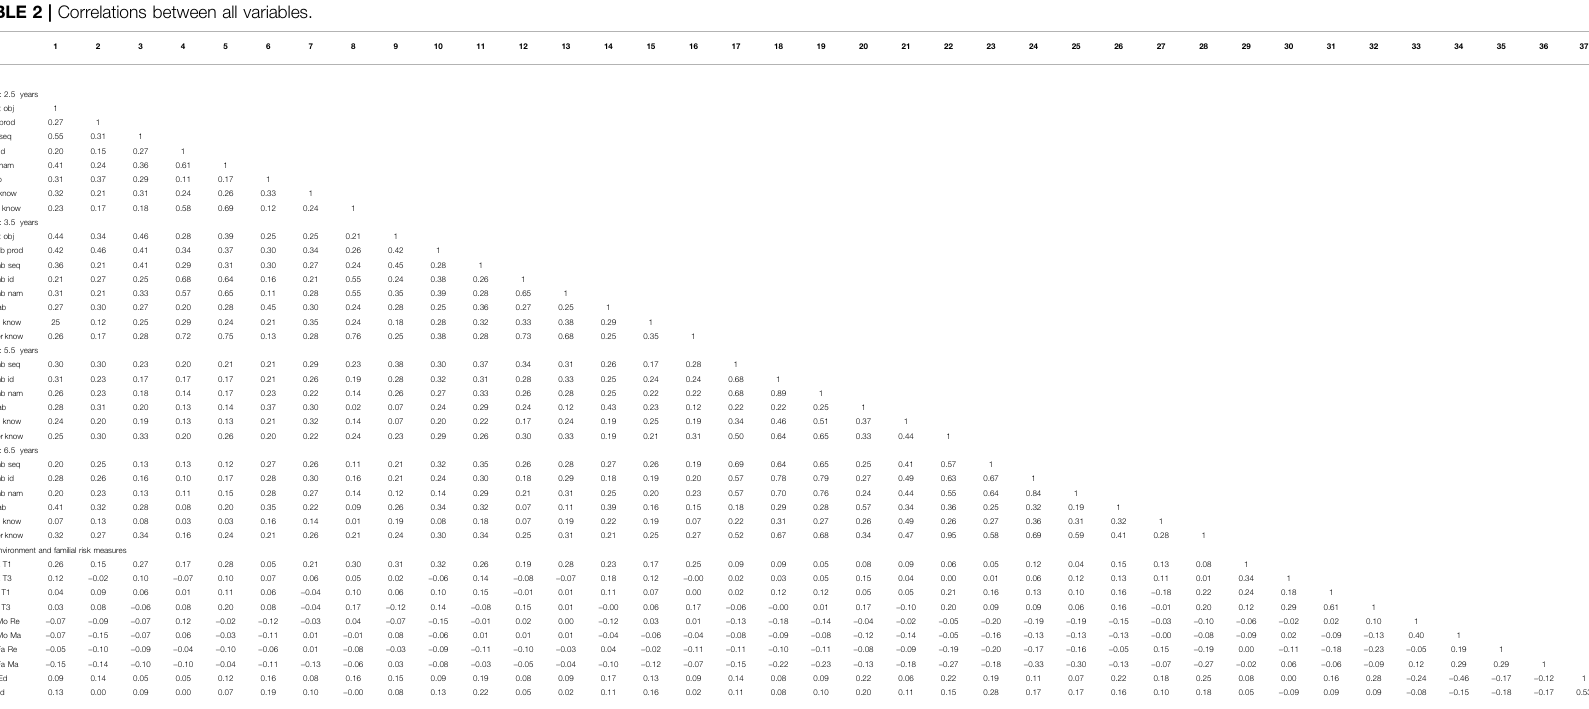
TABLE 2 | Correlations between all